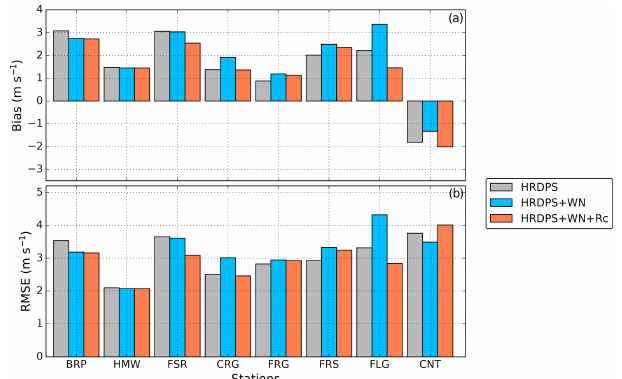
Figure 4. Evaluation of simulated wind speed using different down- scaling methods: (a) bias and (b) root-mean-square error (RMSE). Grey colours show the HRDPS wind speed without downscaling, blue colours show the HRDPS wind speed combined with Wind- Ninja microscale winds (HRDPS + WN) and red colours show the same configuration as HRDPS + WN including in addition the wind speed reduction on leeward slopes. Stations used for evaluation are classified by increasing TPI (Table 3). Their location is shown in Fig. 1.